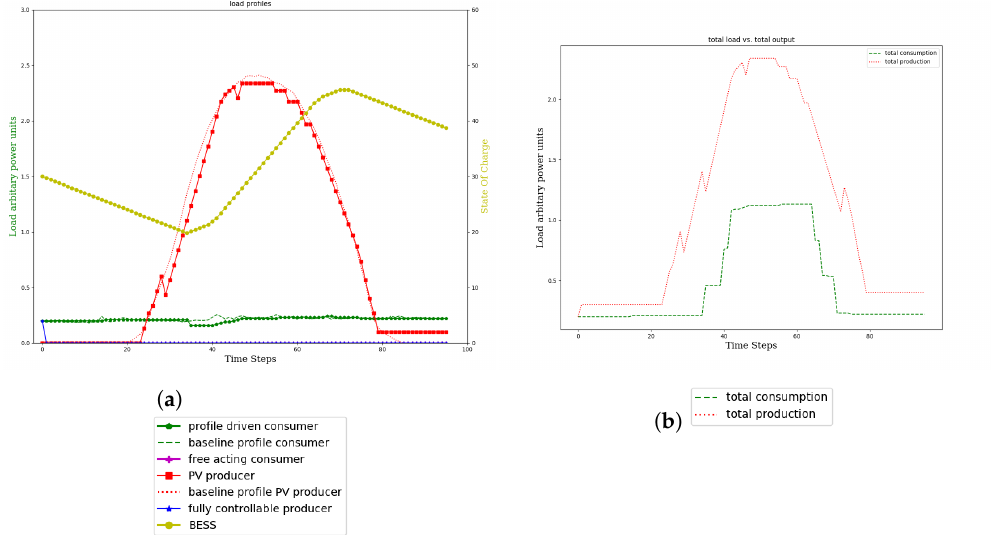
Figure 11. Evaluation on day 3, with agents trained on day 1. ( a ) Agent load curves and profiles. ( b ) Load balancing.